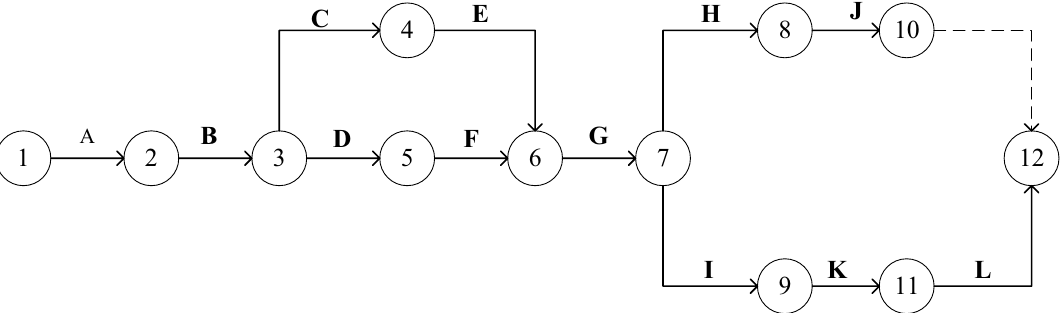
Figure 4. Two-code network plan for an engineering